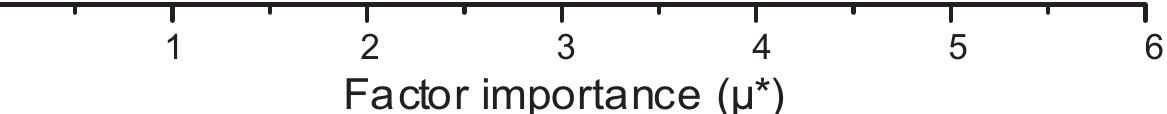
Fig 4. Analysis of the influence and interaction between dynamic factors using the Morris method. The horizontal axis is the mean absolute value of the elementary effect ( μ � ), which represents the influence of a factor on output. The vertical axis is the standard deviation ( σ ), which represents the interaction of a factor with other factors. The dashed line σ = μ � represents point at which interaction with other factors equals the influence on output.